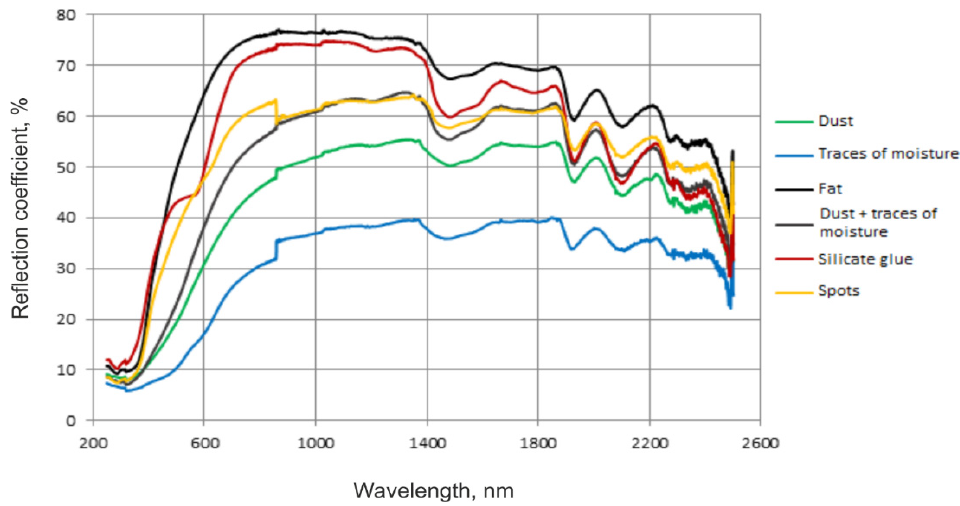
Figure 2. Reflection coefficient of paper with contaminants versus laser radiation wavelength.